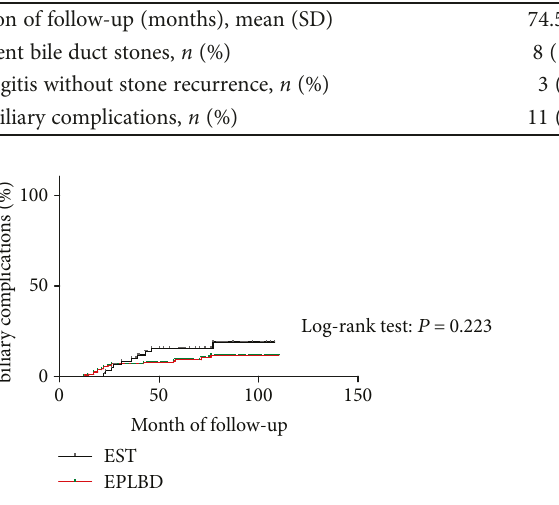
Figure 3: Cumulative incidence of late biliary complications. The red line indicates the EPLBD group, and the black line corresponds to the EST group. Kaplan-Meier estimates of the proportion of patients with late biliary complications in the endoscopic sphincterotomy (EST) ( n = 59 ) and endoscopic papillary large balloon dilation alone (EPLBD) ( n = 157 ) groups ( P = 0 223 by log-rank